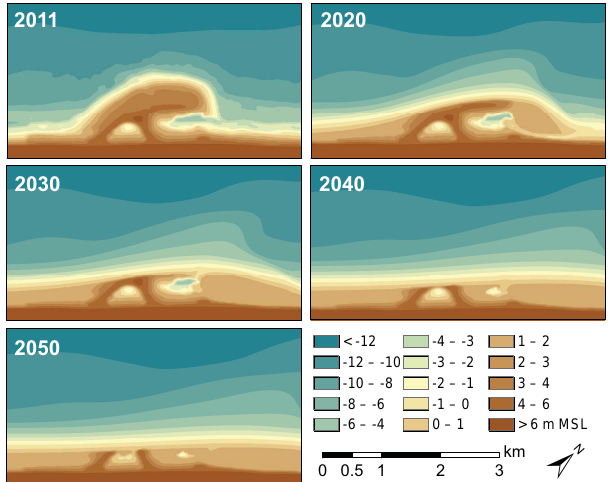
Figure 6. Simulated morphological development of the Sand En- gine from 2011 to 2050, illustrated by contour maps with the terrain elevation (ma.m.s.l.).